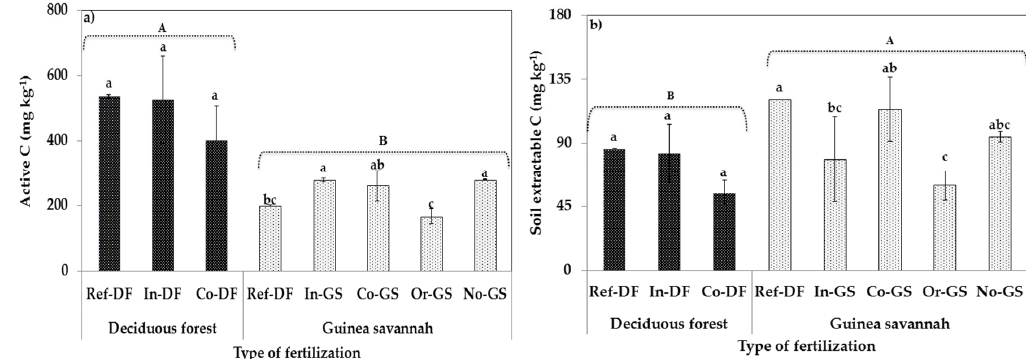
Figure 2. Active Carbon ( a ), soil extractable C ( b ) at depth (0–15 cm) of different types of fertilization. Treatment code: Ref ‐ DF, reference DF site; In ‐ DF, inorganic fertilization at DF; Co ‐ DF, inorganic fertilizer, with low ‐ to ‐ medium organic residues at DF; Ref ‐ GS, reference site; In ‐ GS, inorganic fertilization at GS; Co ‐ GS, inorganic fertilizer, with low ‐ to ‐ medium organic residues at GS; Or ‐ GS, sole low ‐ to ‐ medium organic residues at GS and No ‐ GS, no fertilization input at GS. The error bar indicates the standard deviation of three replicates. Small letters (a, b) represent mean differences among fertilization types in each ecological zone and capital letters (A, B) represent mean the difference between the two ecological zones.